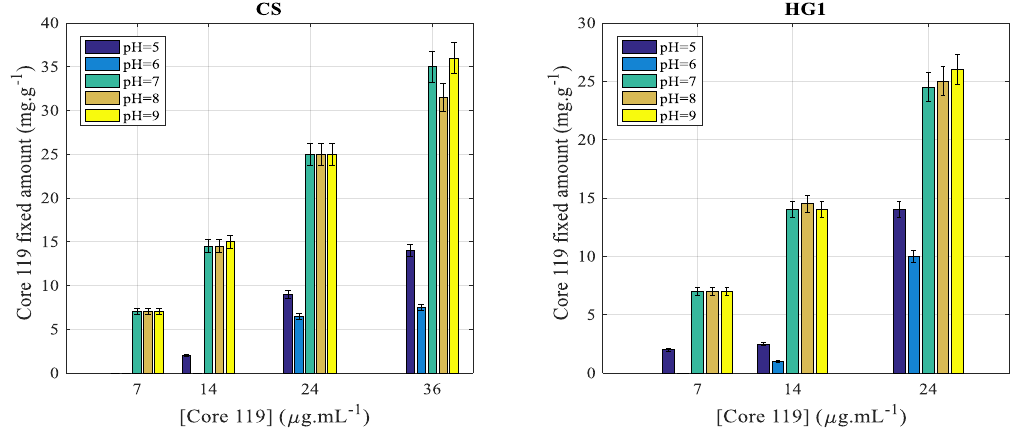
Figure 8. Effect of protein concentration on the complexation amount for CS and HG1 at pH ranging from 5 to 9. The complexation was performed at 20 °C and in the presence of 10-mM nickel ions concentration 3.3. Protein extraction study.